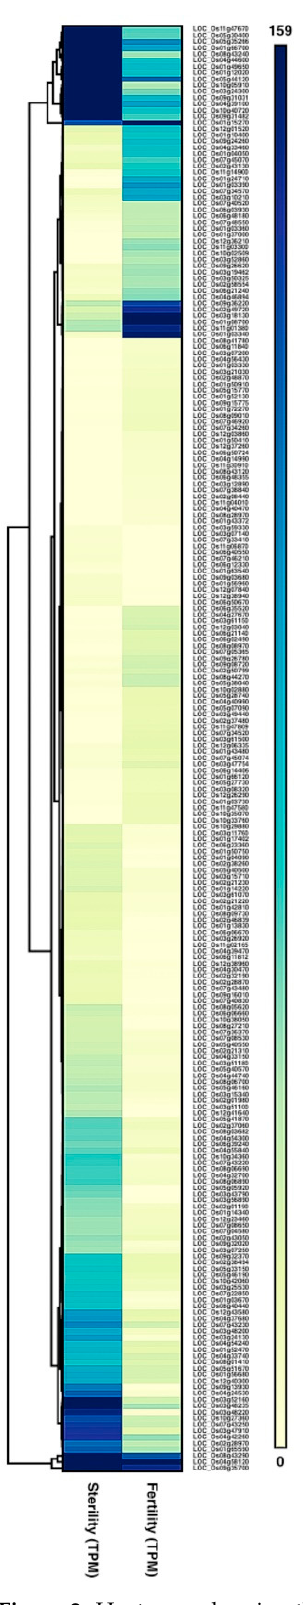
Figure 2. Heat map showing the expression patterns of differentially expressed genes in panicles under the fertile and sterile